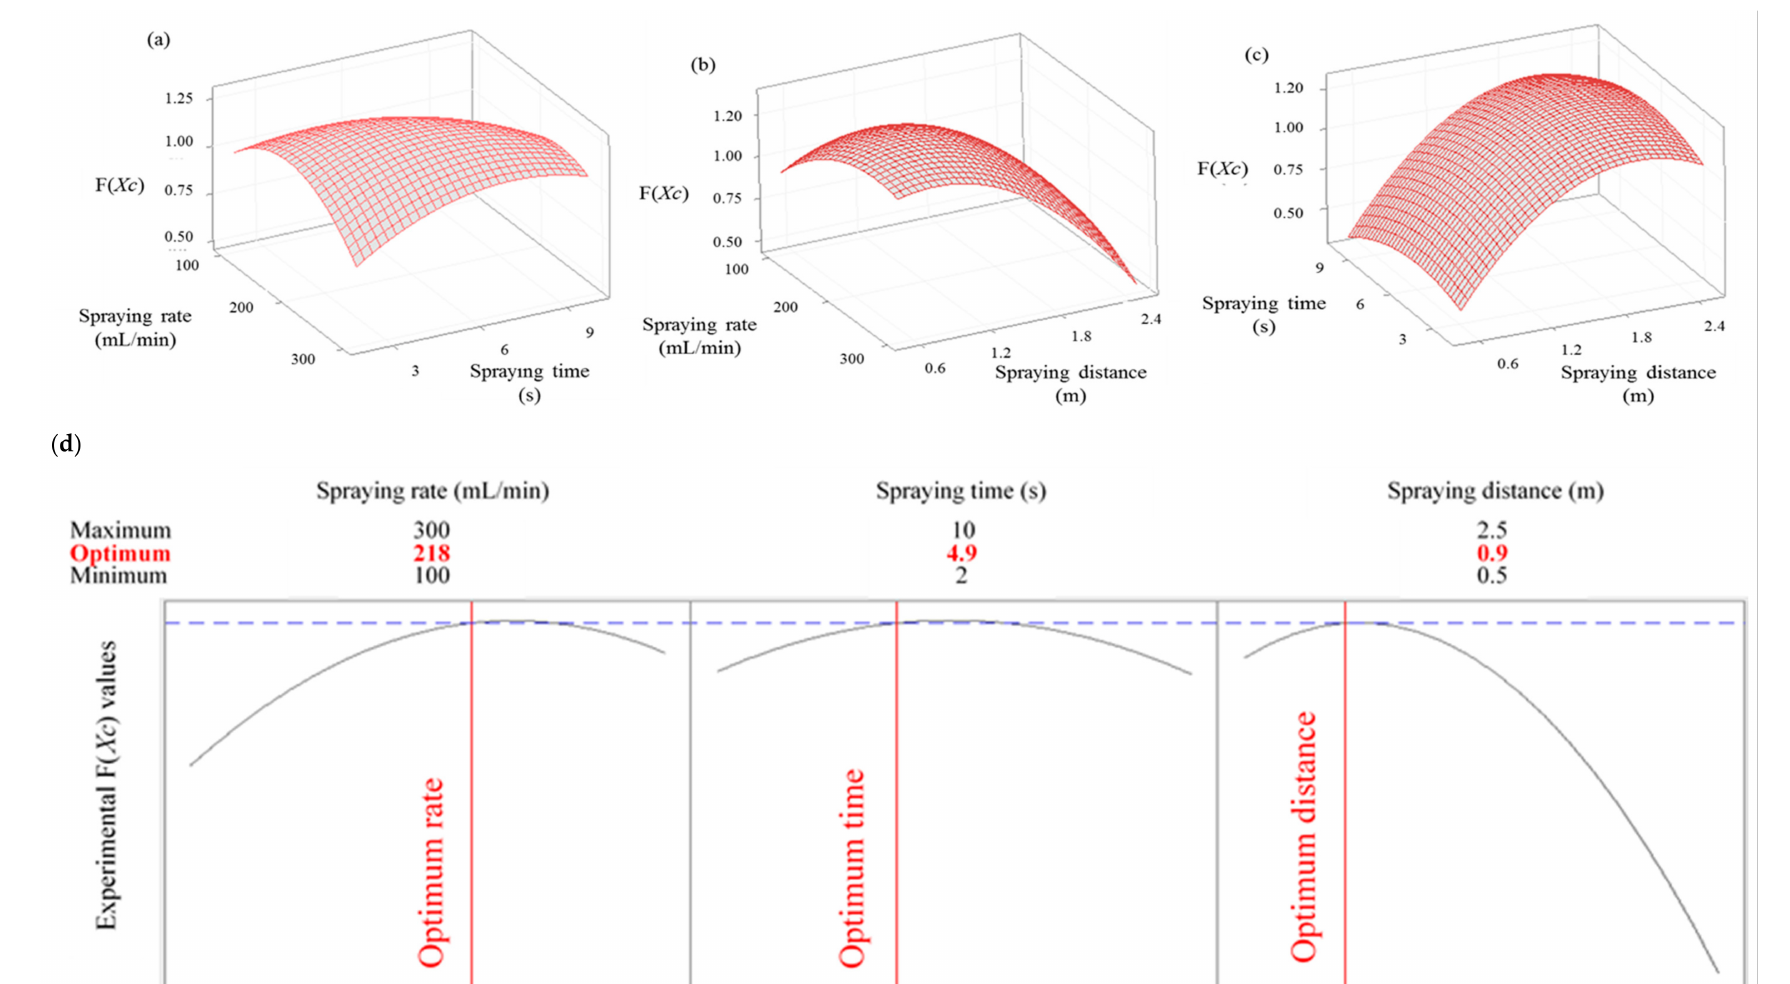
Figure 3. Three-dimensional response surface plots for the color response values (F( X C )) from the dispersion and contact pattern of SAEW spray droplets: ( a ) spraying rate and spraying time, ( b ) spraying rate and spraying distance, ( c ) spraying time and spraying time, ( d ) optimization results for slightly acidic electrolyzed water spray under different conditions, according to the response surface methodology. Multiple optimization graphs of experimental color response values (F( X C